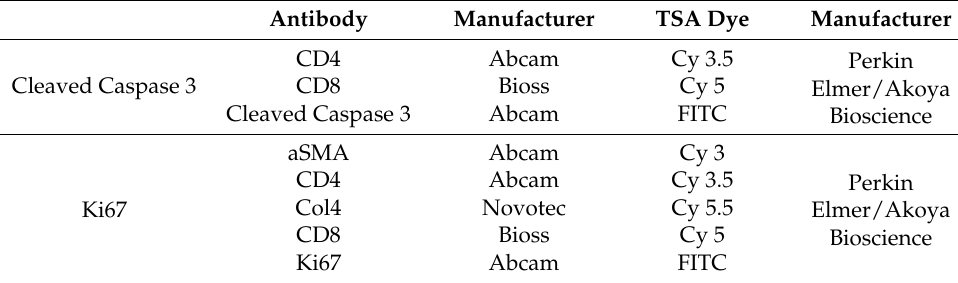
Table 1. Antibody combinations and order for multiplex